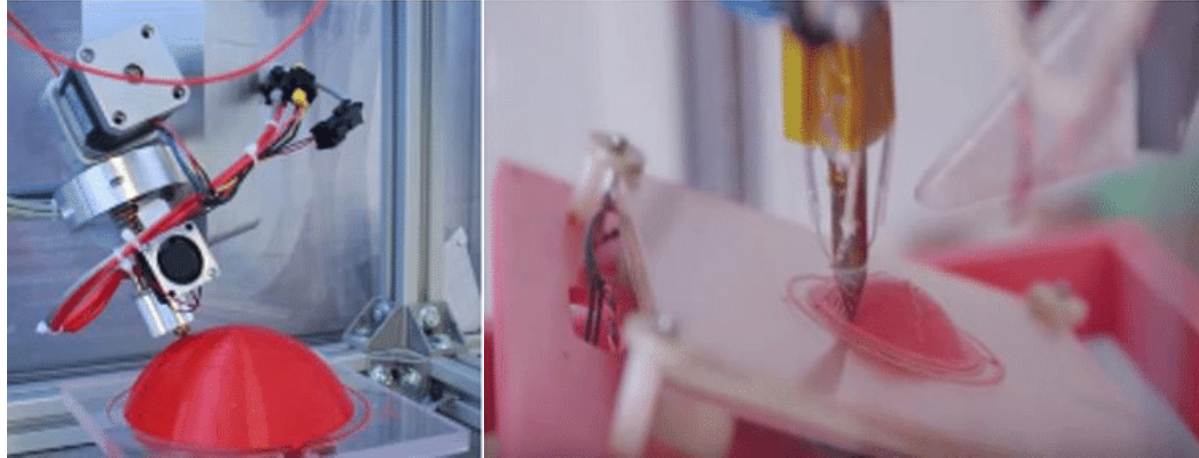
Figure 9. Five-dimensional printed pressure cap [123].